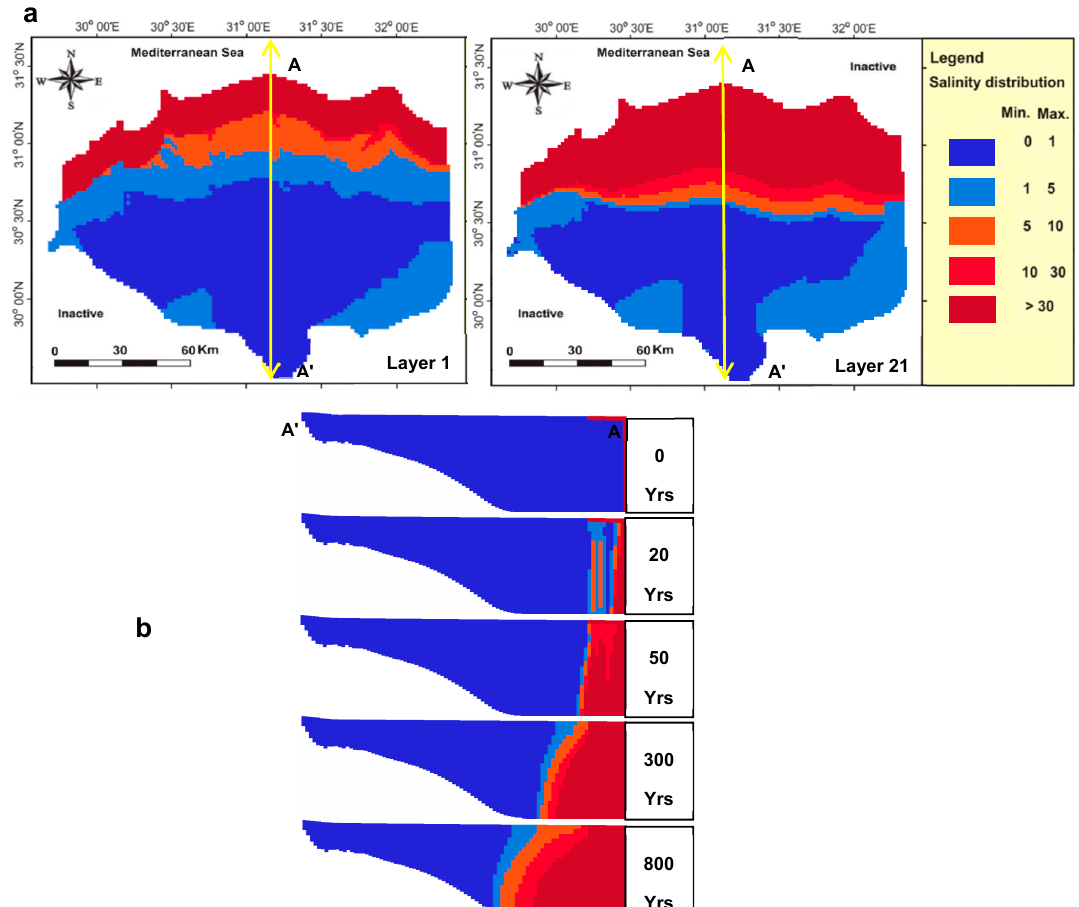
Figure 11. ( a ) The salinity concentration distribution in kg/m 3 in first and last layers for 2010AD (last time step of the model with simulation period of 800 years). ( b ) Salinity concentration distribution along the cross section of the NDA versus time (A–A’).